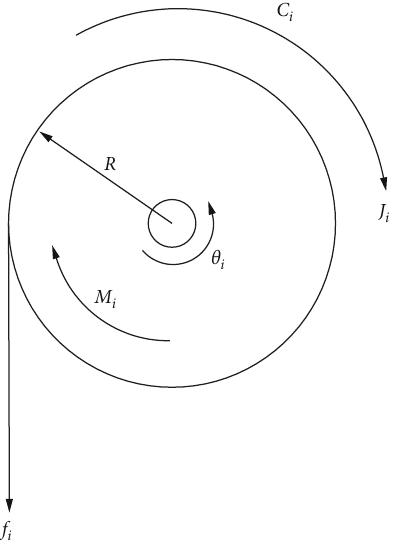
F IGURE 9: Diagram of cable